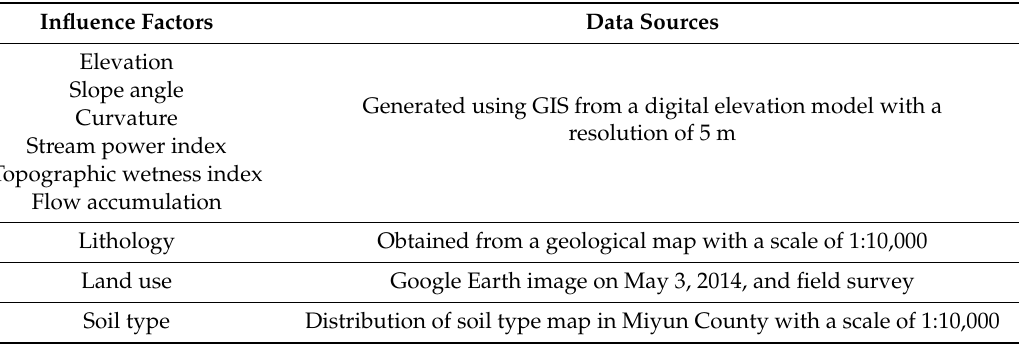
Table 1. A list of data sources of each influencing factor.